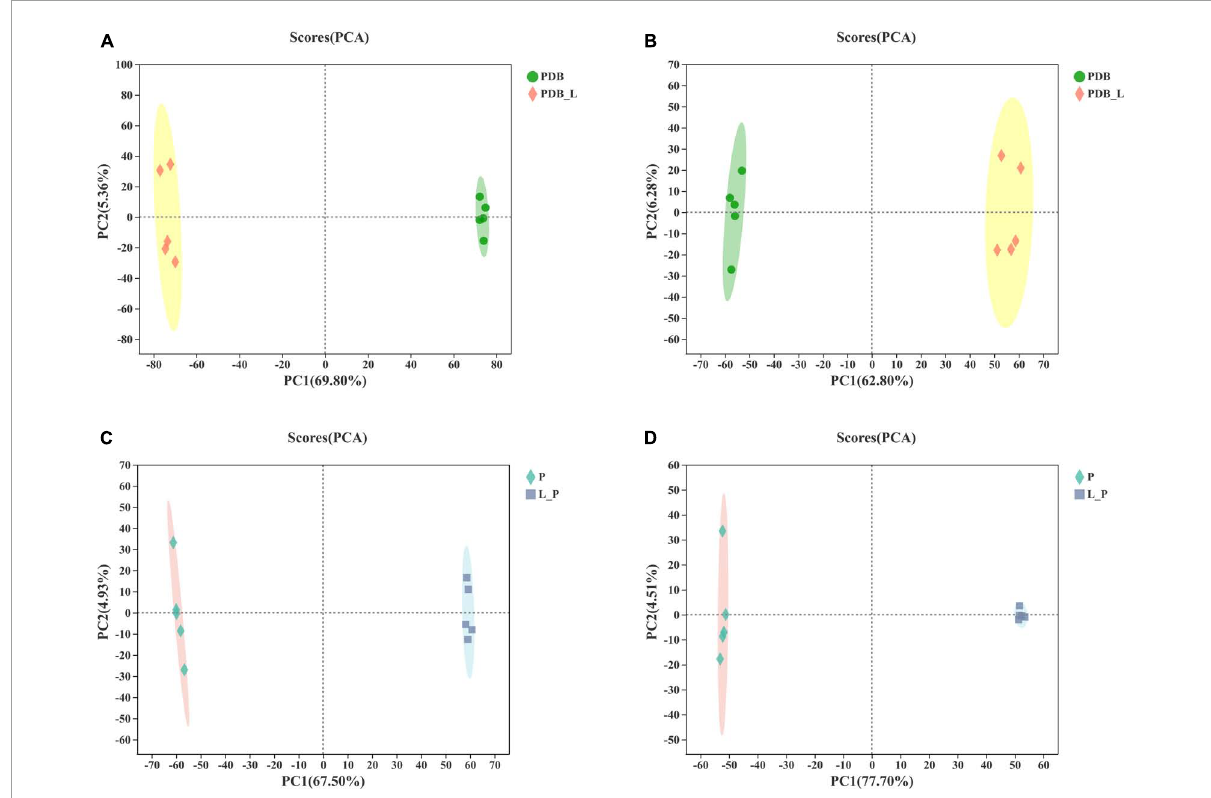
FIGURE3 The score scatter plot of principal component analysis (PCA). PDB and Weissella cibaria BYL4.2-CFS + PDB of positive ion mode (A) and negative ion mode (B) and Penicillium chrysogenum and W. cibaria BYL4.2-CFS + P. chrysogenum of positive ion mode (C) and negative ion mode (D) . PDB, PDB; PDB_L, W. cibaria BYL4.2-CFS + PDB; P, P. chrysogenum ; L_P, W. cibaria BYL4.2-CFS + P. chrysogenum